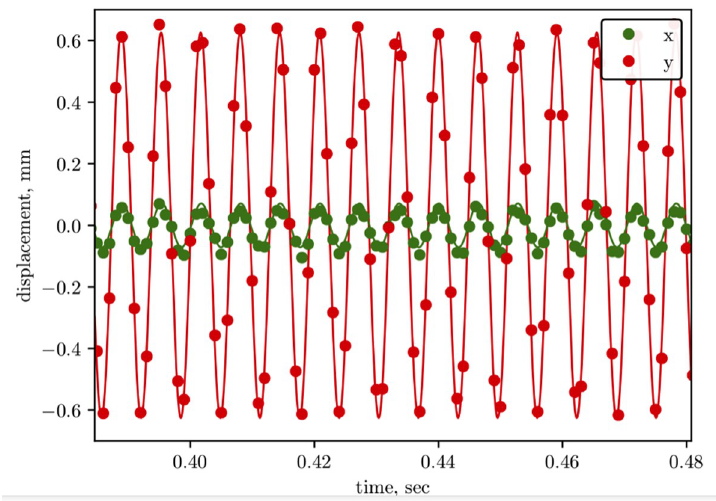
Fig 7. Displacement of the nail head. Displacement of the center of the nail head measured from the recording of an experiment performed stimulating the Notched Stick through the piezoelectrical device applying 156Hz frequency. Dots are the measured data and solid lines the sinusoidal